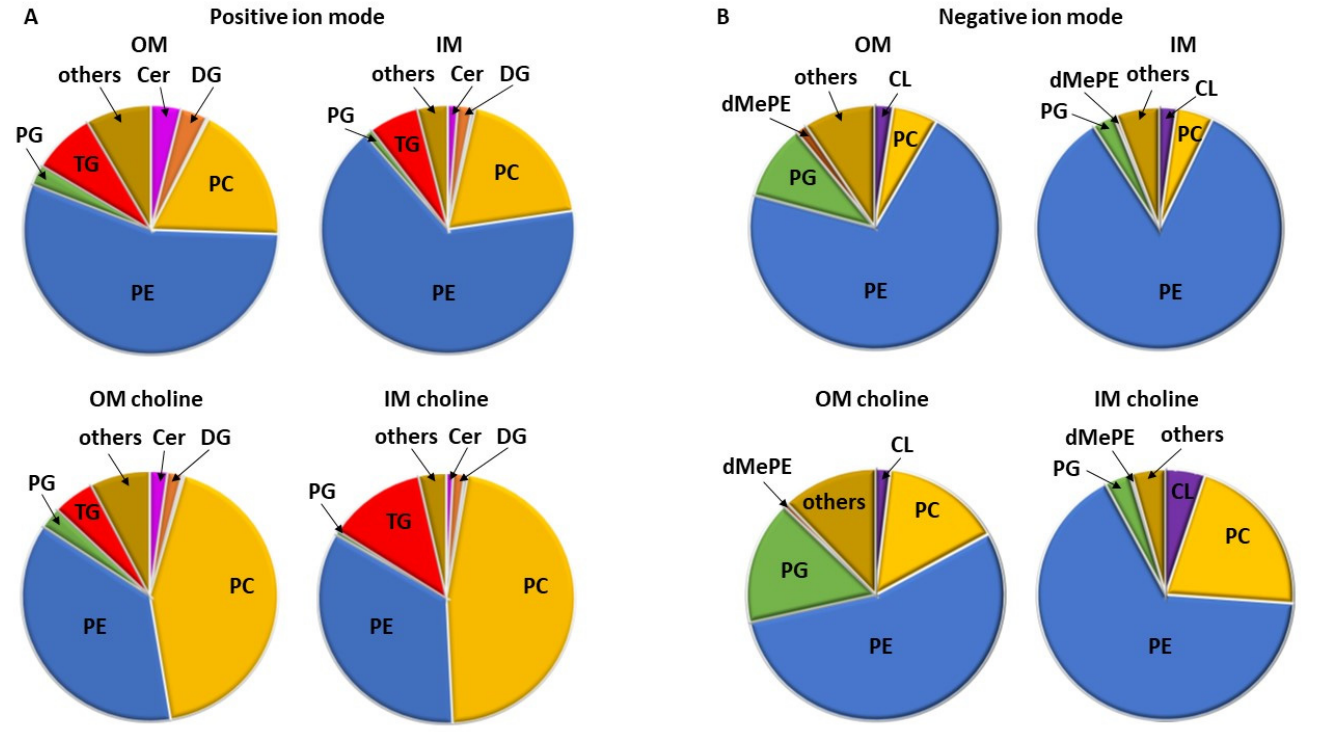
Figure 2. Lipid classes in the OM and IM of L. gormanii grown on a medium with and without the addition of exogenous choline. The lipid classes were analyzed by LC-MS in the positive ( A ) and negative ion mode ( B ).